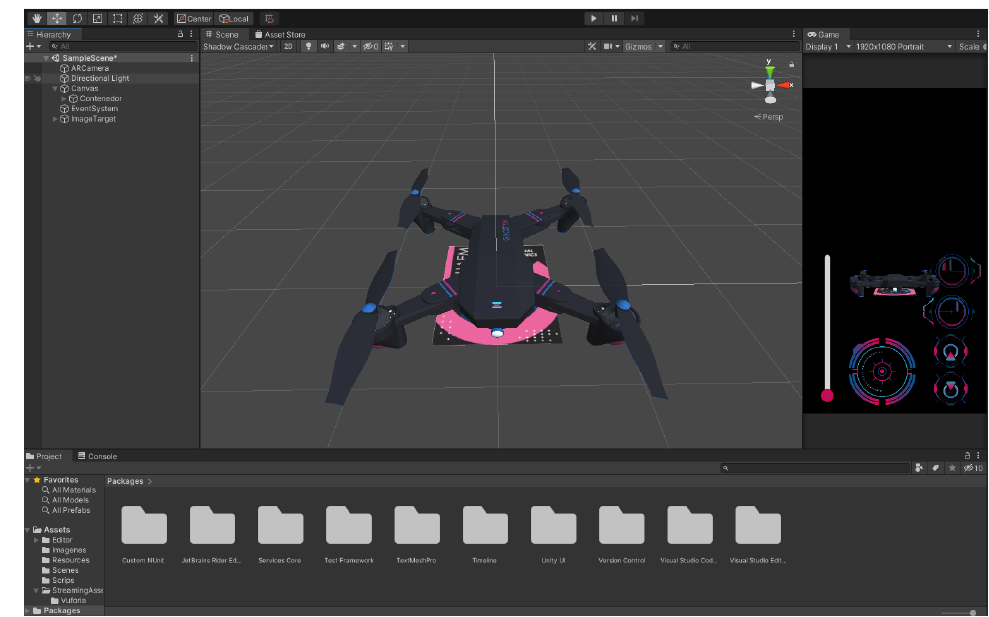
Figure 18. Design of the drone environment in augmented reality using